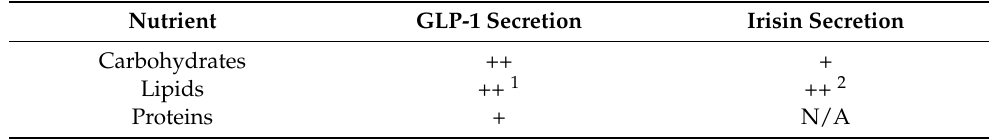
Table 1. Effect of dietary nutrients on secretion of GLP-1 and